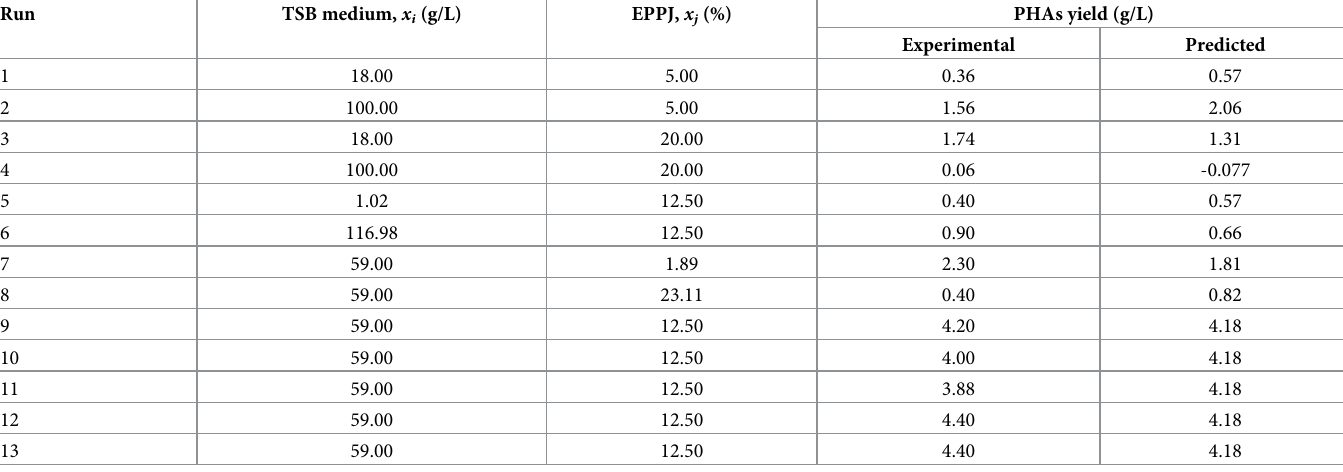
TSB medium was purchased from Becton, Dickinson and Company, MD, USA. EPPJ = Extracted pineapple